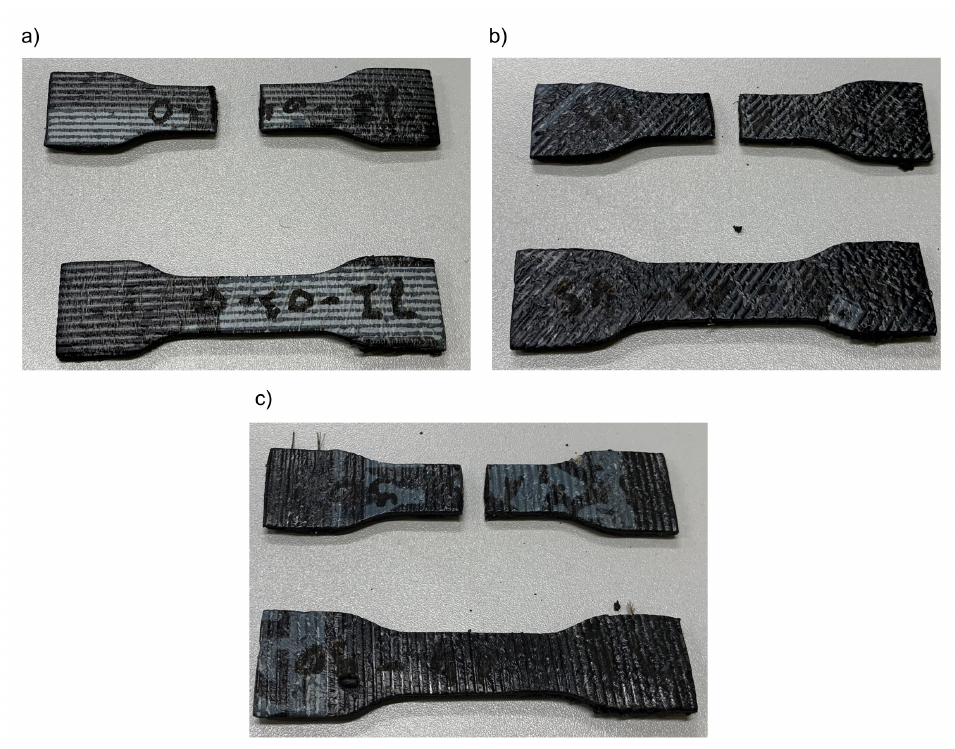
Figure 1. M1 material samples prepared according to [62] with ( a ) 0°, ( b ) 45°, ( c ) 90° angle of reinforcement relative to the sample’s longitudinal axis. Samples cut with a knife.